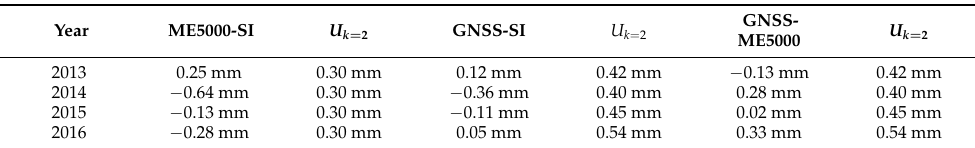
Table 7. Differences between the ME5000, SI-traced and GNSS distances, and their corresponding expanded uncertainties U ( k =